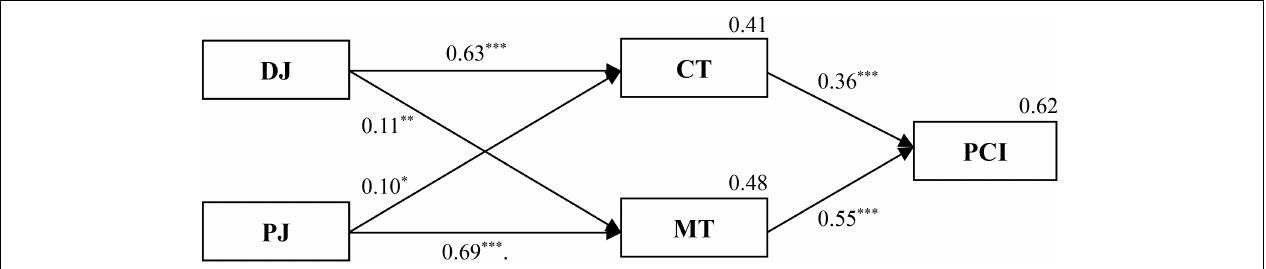
FIGURE 2 | The dual-pathway model of public cooperation intention. n = 165; ∗∗∗ p < 0.001, ∗∗ p < 0.01, ∗ p < 0.05. Model fit indices: χ 2 = 3.01, df = 3, p = 0.39; CFI = 1.00, NFI = 1.00, RMSEA < 0.01.